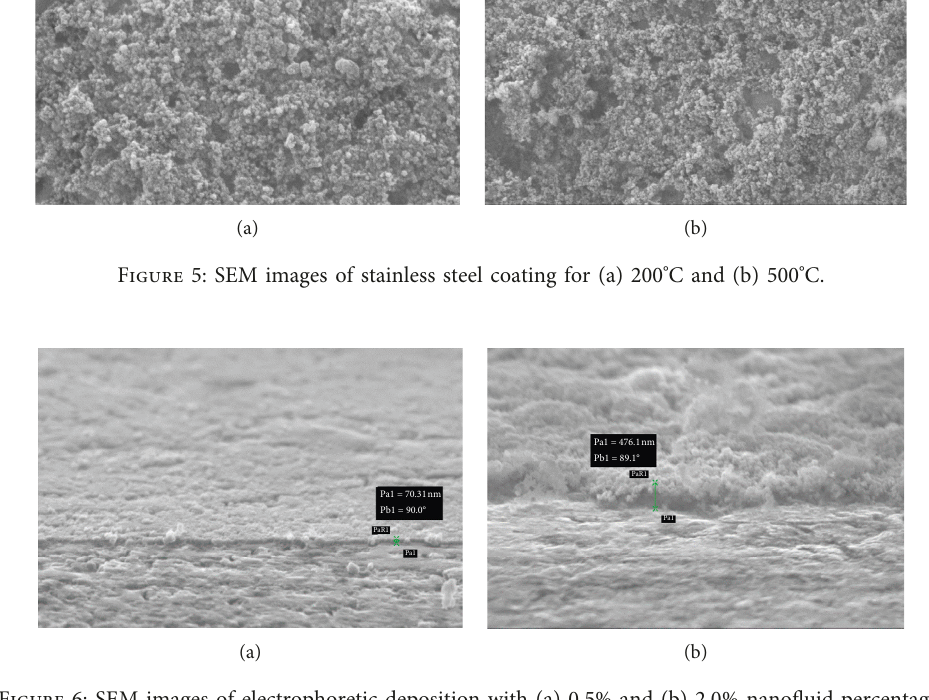
Figure 6: SEM images of electrophoretic deposition with (a) 0.5% and (b) 2.0% nanofluid percentage.